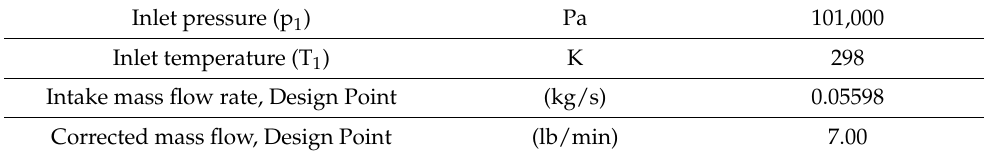
Table 1. Air inlet conditions (British units shown for comparison with original Garrett documentation).